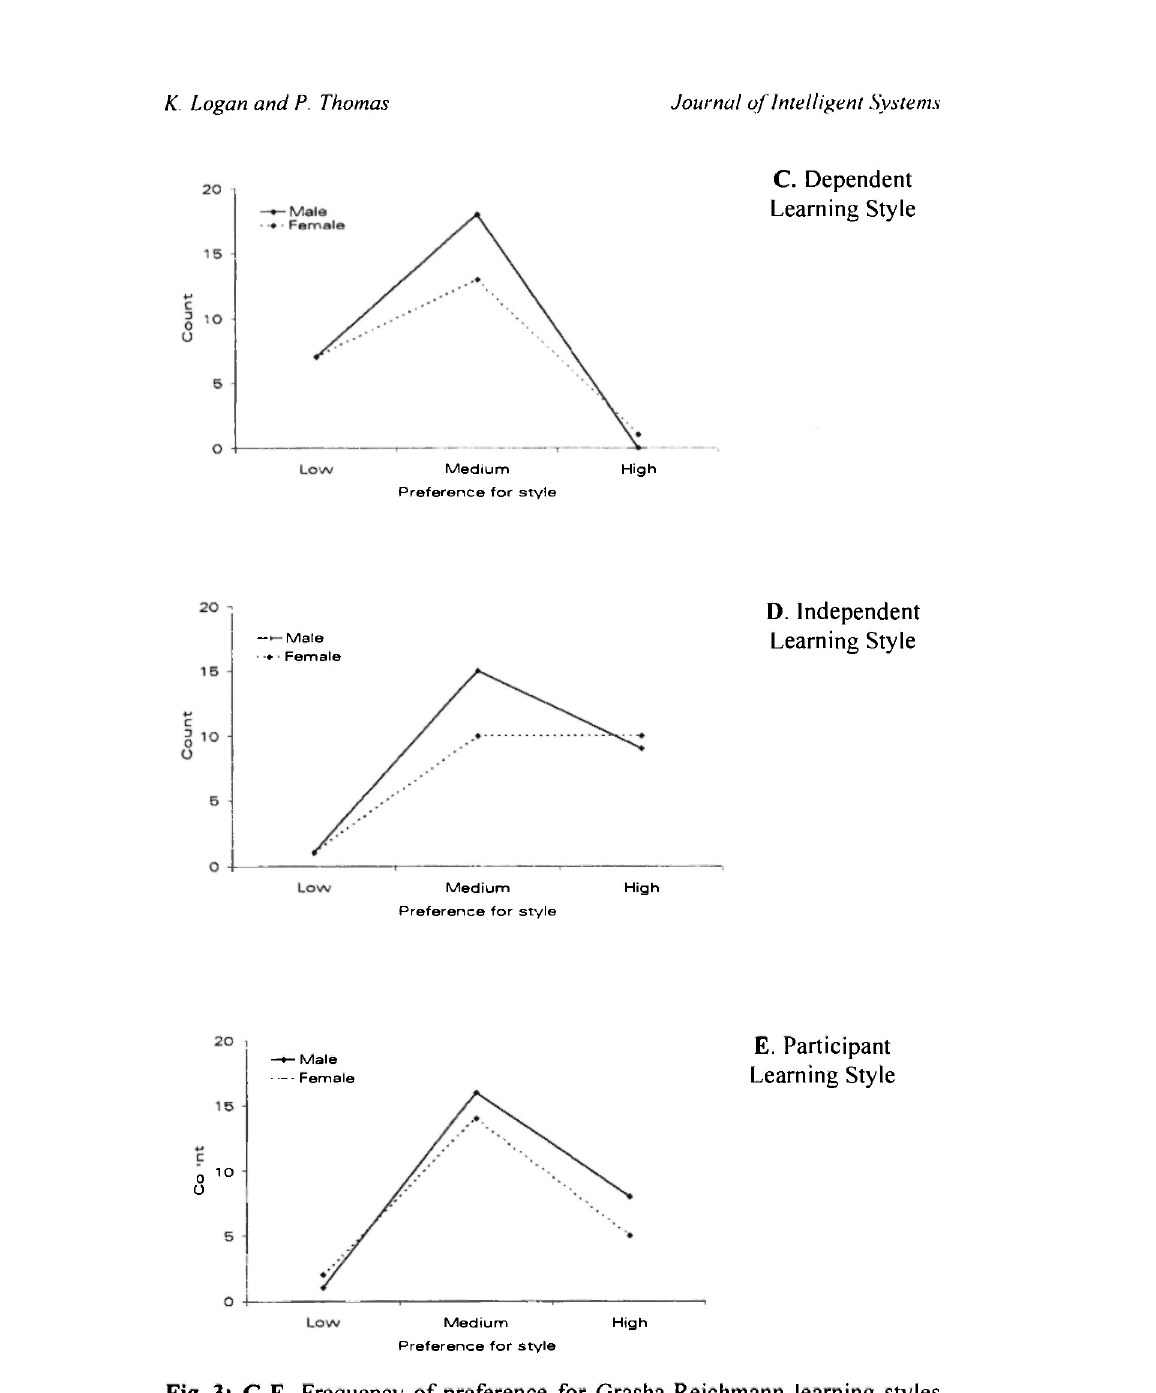
Fig. 3: C-E, Frequency of preference for Grasha-Reichmann learning styles by